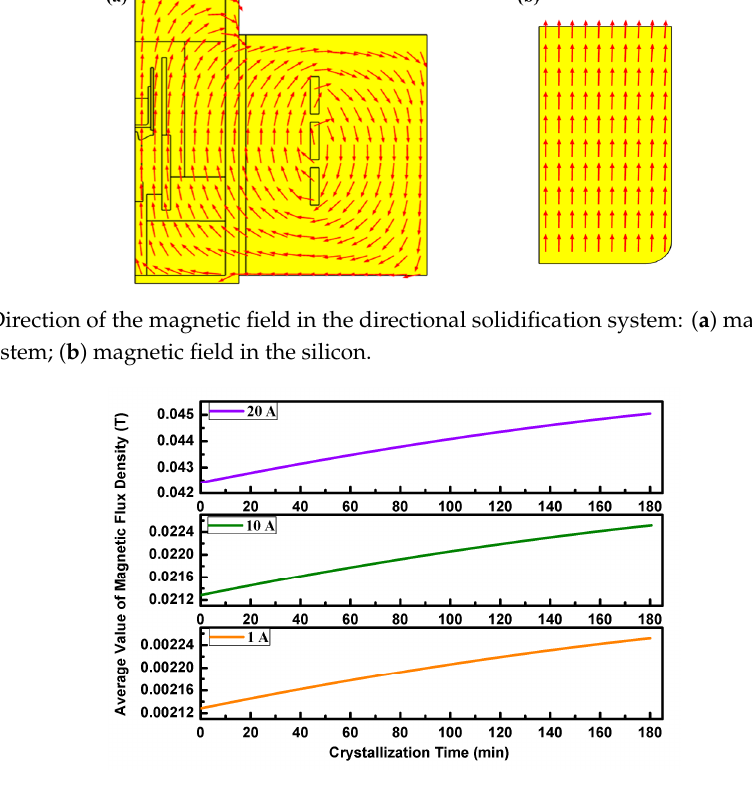
Figure 4. The average value of the magnetic flux density in the silicon during crystallization.